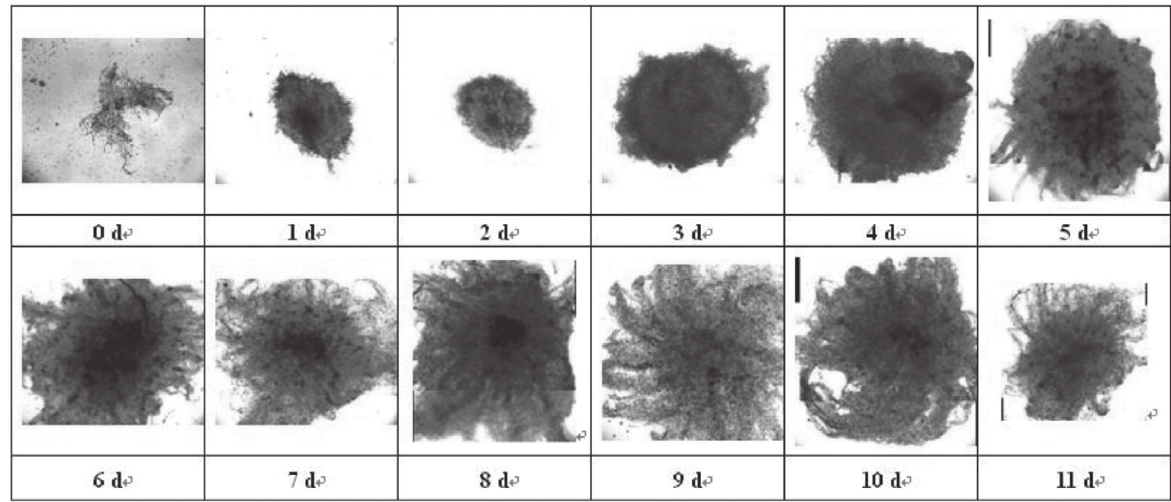
Fig. 3 - The morphological changes in P. geesteranus 5 # in a stirred-tank fermenter. Representative images were taken at 40-fold magnification. 1-9d means fermentation period in